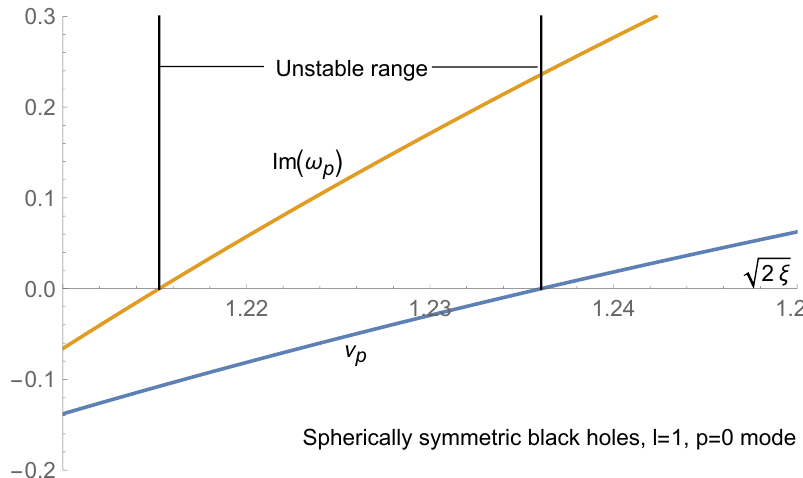
Figure 1 . Frequency ω p and ν p on the spherically symmetric black hole γ = 1 , for the non-minimally coupled scalar with non-minimal coupling ξ , on the mode with p = 0 and angular momentum l = 1 . The allowed modes correspond to values of ξ such that ν p < 0 . The modes with frequencies with positive imaginary part are unstable. In consequence, stability sets an upper bound on the value of the non-minimal coupling